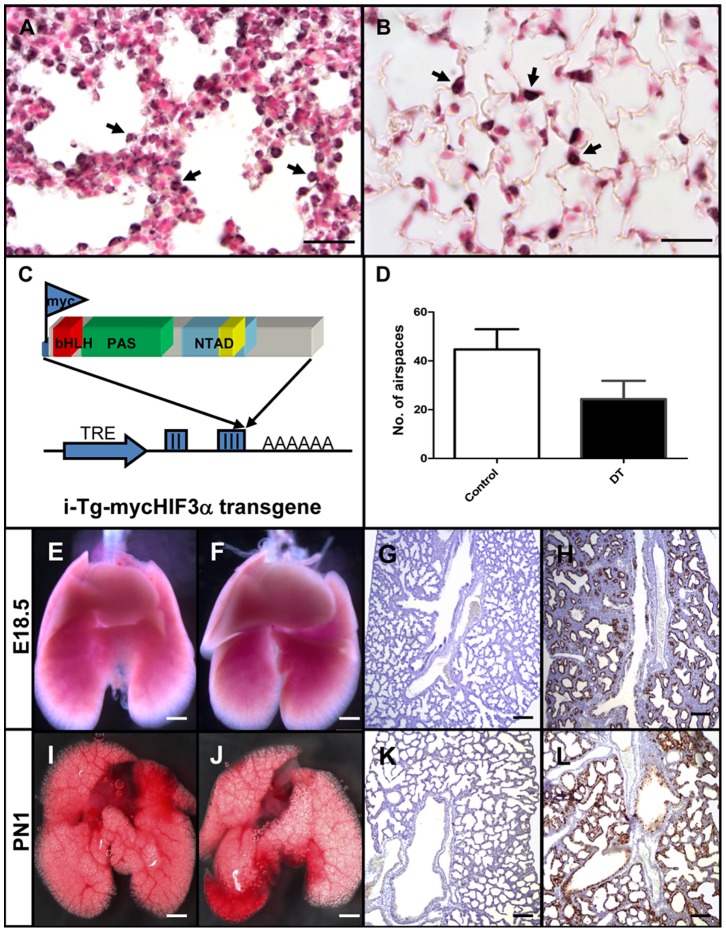
Enhanced expression of HIF3α results in late branching defect.Endogenous expression of Hif3α was detected in epithelial cells at gestational age E18.5 (A, arrows) and in type II pneumocytes in adult mice (B, arrows). (C) Graphic representation of the tet-inducible Hif3α/NEPAS cDNA construct used to generate transgenic mice. TRE is the Tet-responsive element containing minimal promoter, II and III refer to exon 2 and 3 of the ß-blobin gene and AAAAAA is the poly-adenylation signal. Indicated are the position of the myc-epitope, and the bHLH, PAS and NTAD domains (see text) (D) Quantification of the number of airspaces in the lung. Three independent samples of control and double-transgenic lungs at gestational age E18,5 were used to count the number of airspaces. External appearances of control (E, I) and double transgenic mycHIF3α (F, J) lungs at E18.5 days of gestation (E18.5) and post natal age 1 (PN1) do not show apparent differences. Histological analysis of control (G, K) and double transgenic lungs (H, L) showed decreased number of alveolar spaces and reduced branching in the double transgenic lungs (H and L). Anti-Myc epitope staining confirmed the expression of the mycHIF3α transgene in double transgenic lungs (H and L), which is absent in control lungs (G and K). Scale bars: Scale bars: 25 µm (A, B), 2 mm (E, F, I, J) or 200 µm (G, H, K, L).